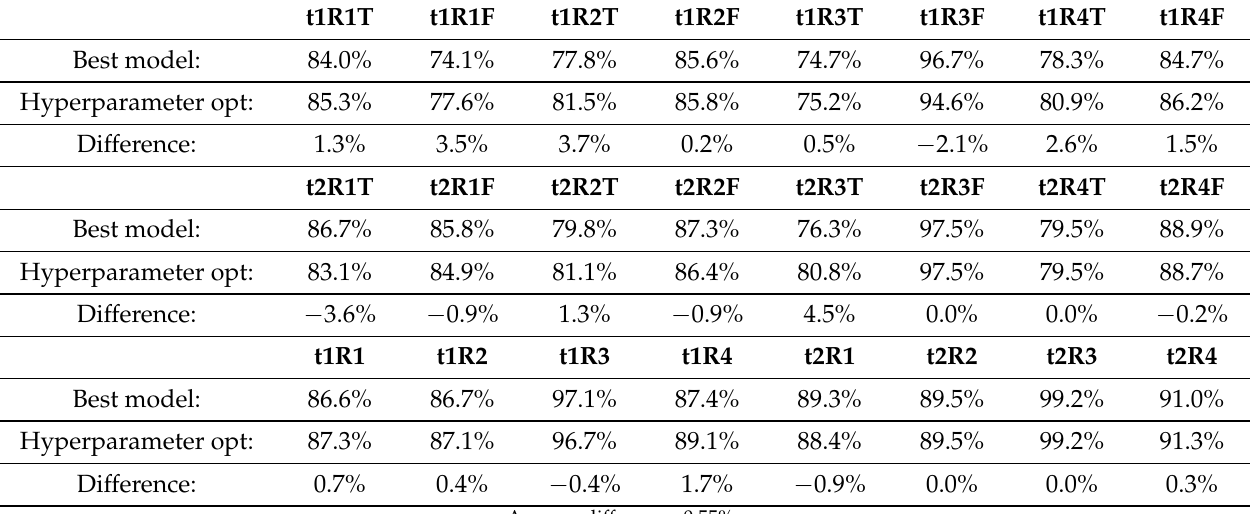
Table 5. Results of prediction accuracy after hyperparametric optimization, “Hyperparameter opt”-best model with hyperparameter optimization, “Difference”-Difference between result with and without hyperparameter optimization, “Avr. difference”-average difference from all